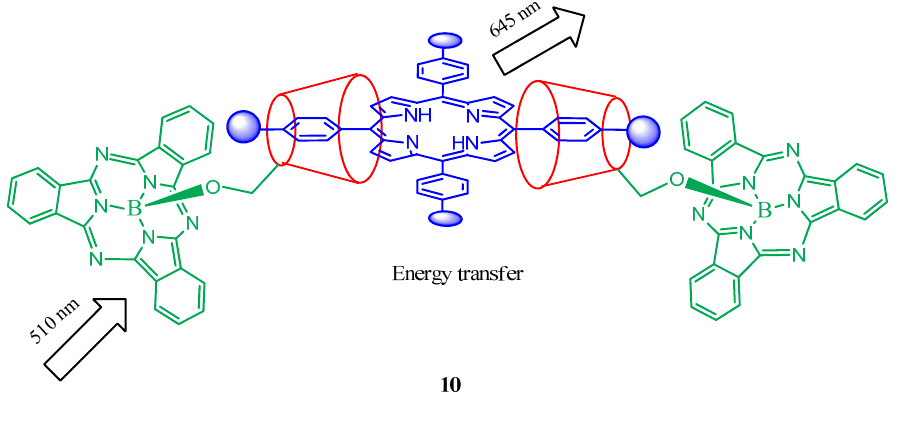
Figure 10. Representation of the 2:1 host-guest complex ( 10 ) formed by a β -cyclodextrin-conjugated subphthalocyanine and tetrasulfonated porphyrin and its energy transfer